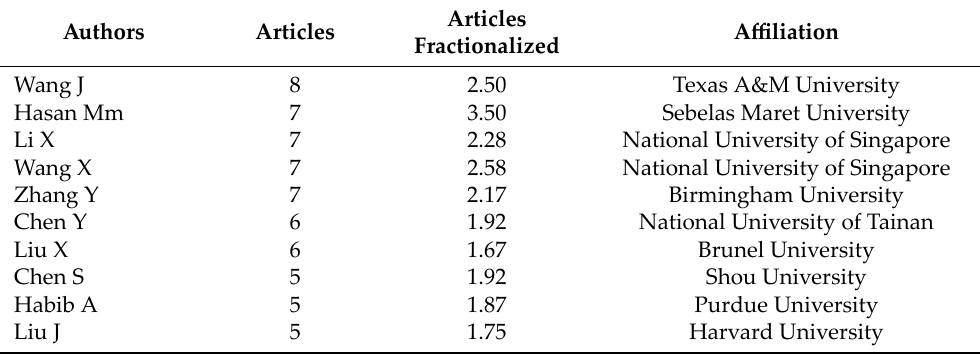
Table 4. Top 10 relevant authors based on the number of publications. Source: Scopus/Biblioshiny (Own